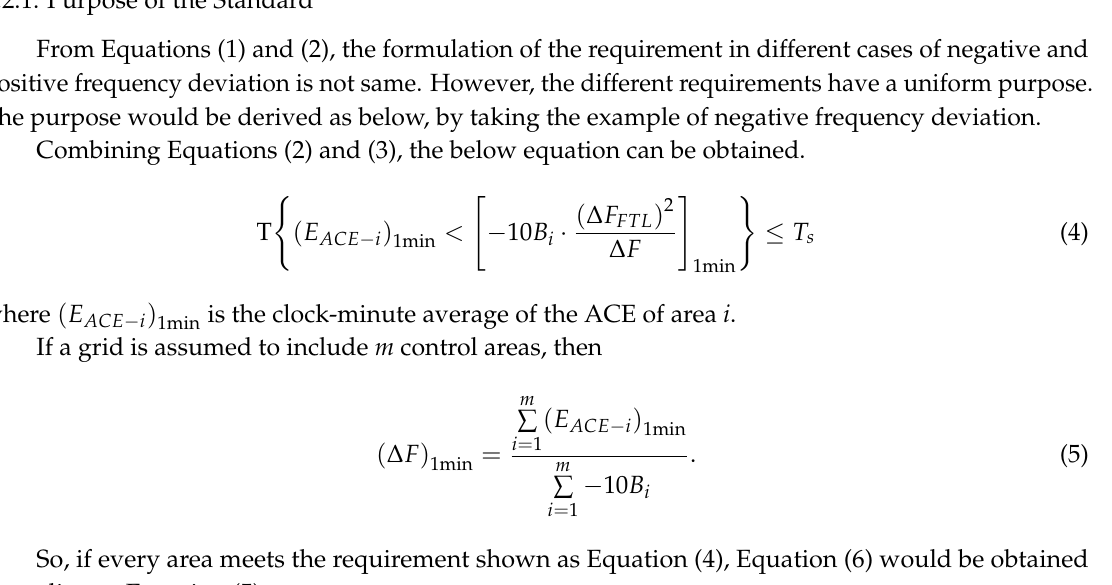
Table 1. Violation severity level of the Balancing Authority Area Control Error (ACE) Limit (BAAL) Standard. Violation Level Description Low Duration of over-limit ACE is between 30 min and 45 min Moderate Duration of over-limit ACE is between 45 min and 60 min High Duration of over-limit ACE is between 60 min and 75 min Severe Duration of over-limit ACE is larger than 75